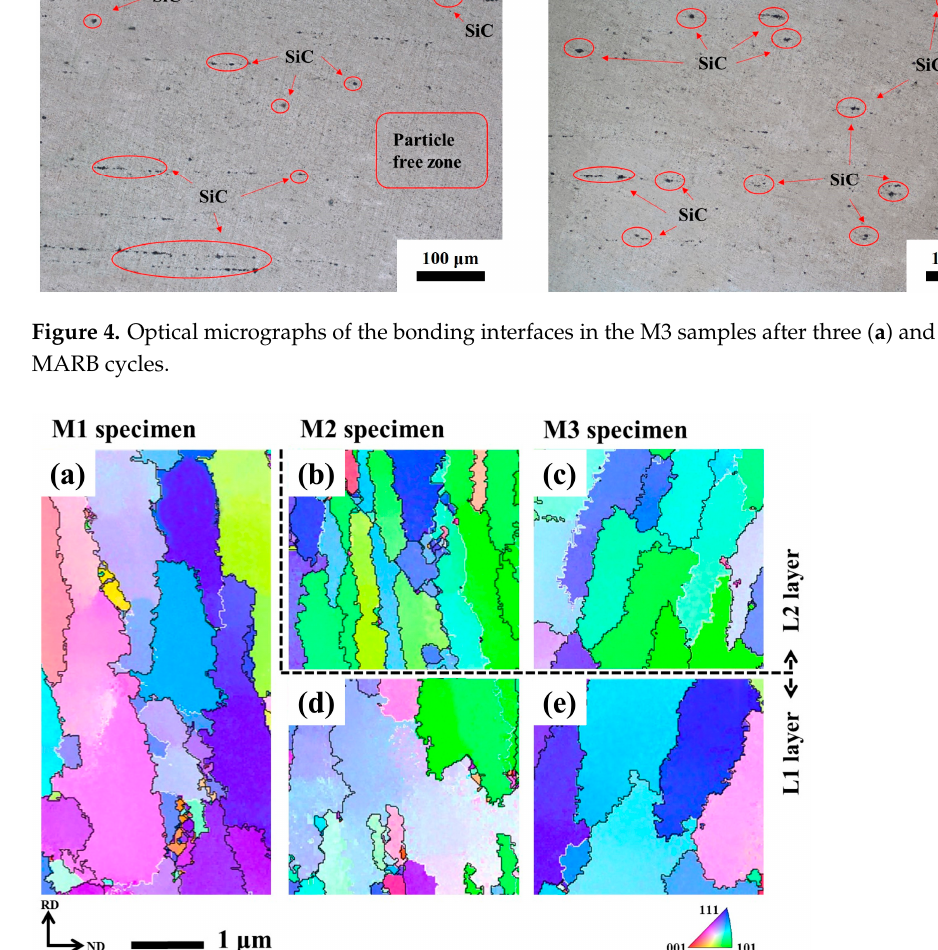
Figure 6. AGS distribution for the ( a ) M2 and the ( b ) M3 samples. Figure 7 demonstrates the {111} pole figures (PFs) for the M1 (Figure 7a), M2 (Figure 7b) and M3 (Figure 7c) samples after three cycles. The positions of ideal orientation for the Cube {001} <100>, Goss {011} <001>, Brass {011} <211>, S {123} <634> and Copper {112} <111> texture components were marked in the {111} PFs [30,31]. It was observed that in the M1 (Figure 6a) specimen, the main texture components were the S {123} <634> com- ponent with an intensity of 2.1 × R, and the weak texture showing in M1 were Cube {001} <100> and Brass {011} <211> with an intensity of 1.6 × R and 1.2 × R. In the case of the M2 samples (Figure 7b), the main texture components were Brass {011} <211> and S {123} <634> with a maximum intensity of 5.5 × R and 2.4 × R. A weak Cube {001} <100> texture component was also present in the M2 samples with an intensity of 1.2 × R. The texture components of the M3 samples (Figure 7c) could be characterized as Brass {011} <211>, S {123} <634> and Cube {001} <100> with a maximum intensity of 3.8 × R, 2.2 × R and 1.3 × R, respectively.